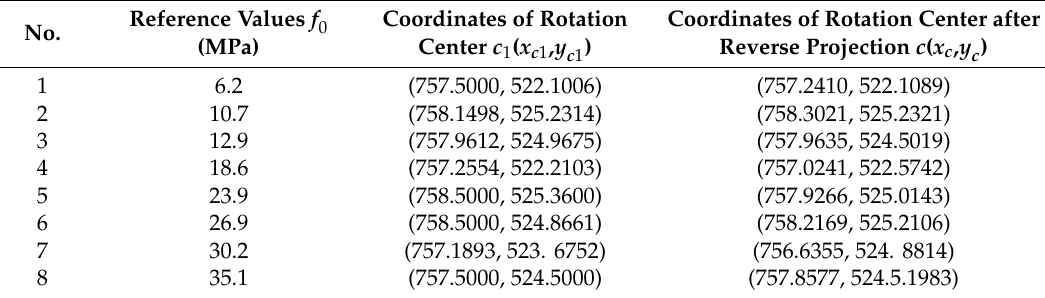
Table 3. Comparison for the pixel coordinates of rotation center.